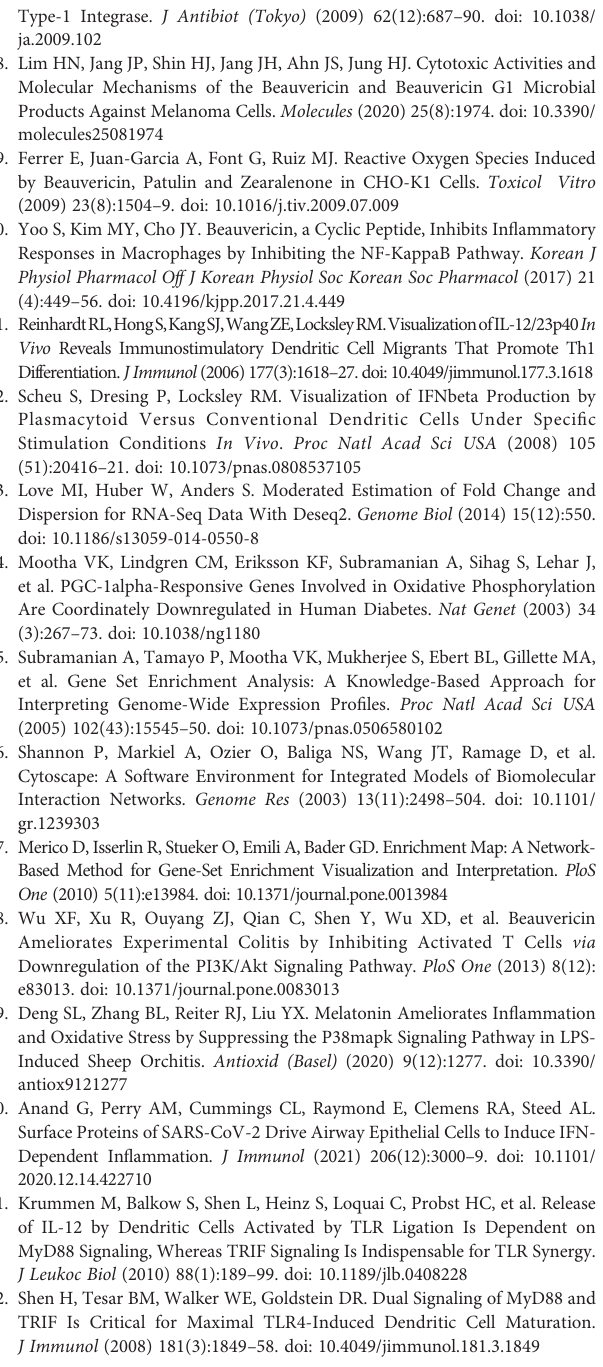
Supplementary Figure 5 | Transcriptional changes in BMDCs after treatment with LPS and LPS in combination with BEA. (A) Cytoscape representation of signi fi cantly enriched signatures in LPS treated BMDCs compared with untreated BMDCs. (B) Cytoscape representation of signi fi cantly enriched signatures in BEA with LPS treated BMDCs compared with untreated